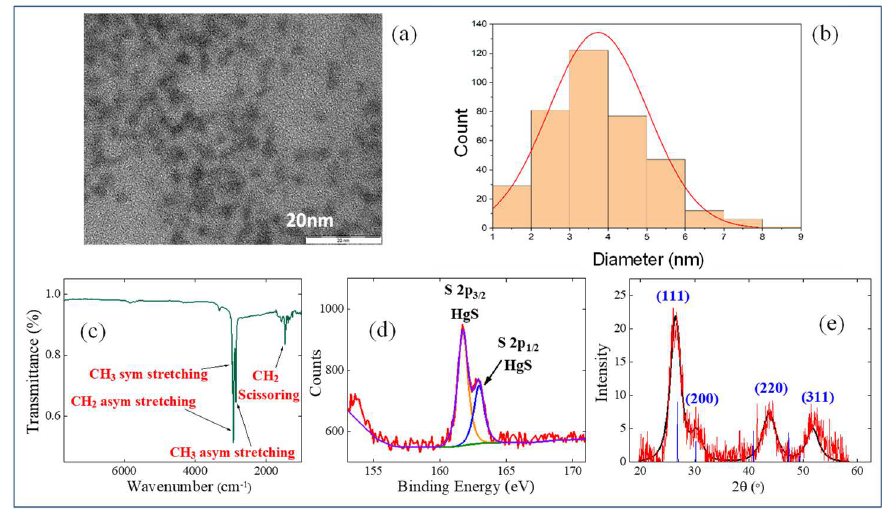
Figure 3. Characterization of sample. ( a ) TEM of HgS QDs. ( b ) Size distribution histogram. ( c ) FTIR spectrum. ( d ) High-resolution XPS. ( e ) XRD of sample.